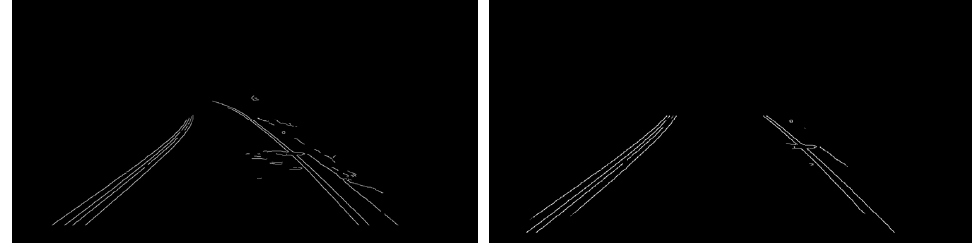
Figure 19. Edge pixels using one trapezoidal ROI ( left ) versus two parallelogram ROI ( right ).